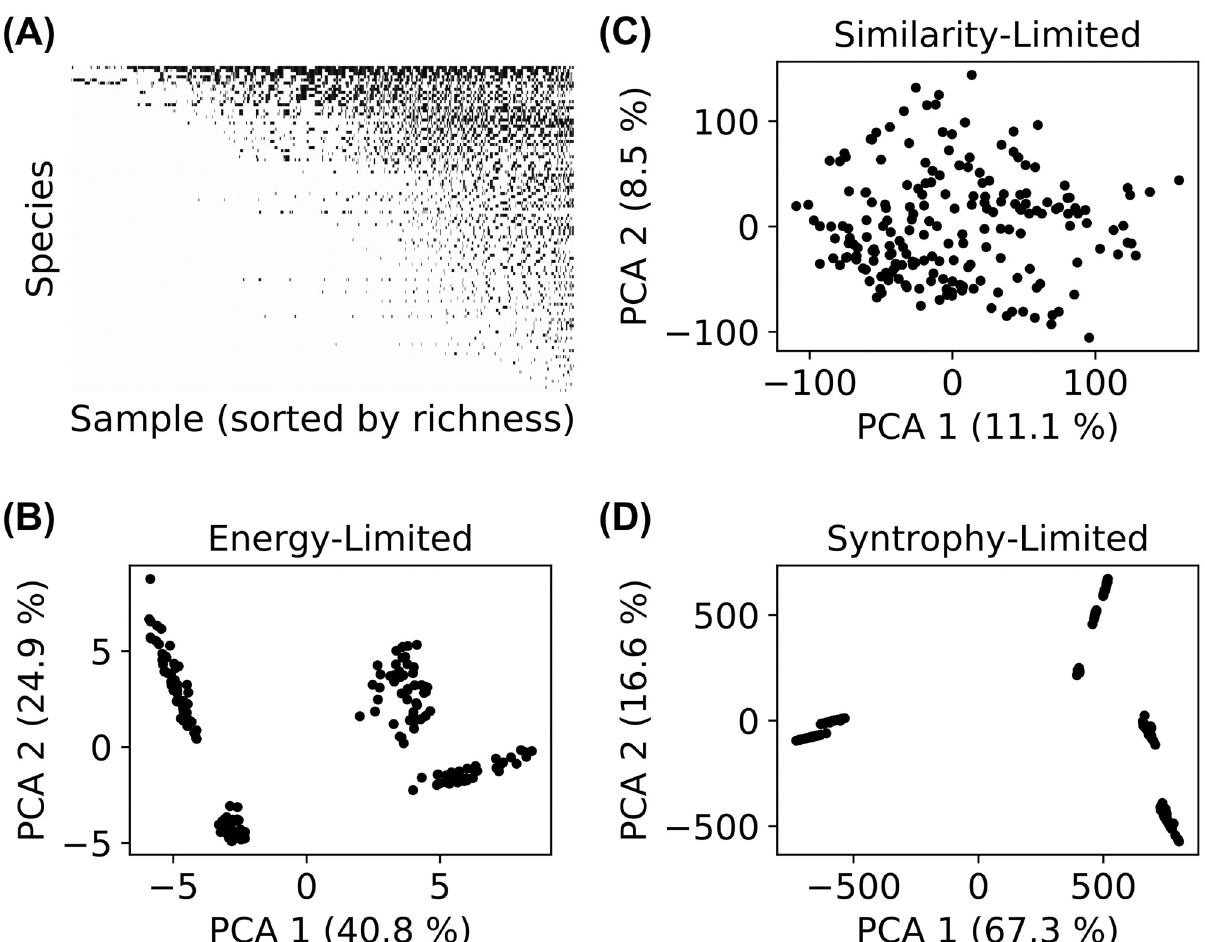
Fig 6. Resource-limited regime features community-level environmental filtering. (A) Presence (black) or absence (white) of all species in all 1,000 communities from the original simulations of Fig 2. (B, C, D) We initialized 200 new communities for each of the three examples highlighted in Fig 2A, by randomly choosing sets of 100 species from the regional pool. Each panel shows the projection of final community compositions { N i } onto the first two principal components of the set of compositions.